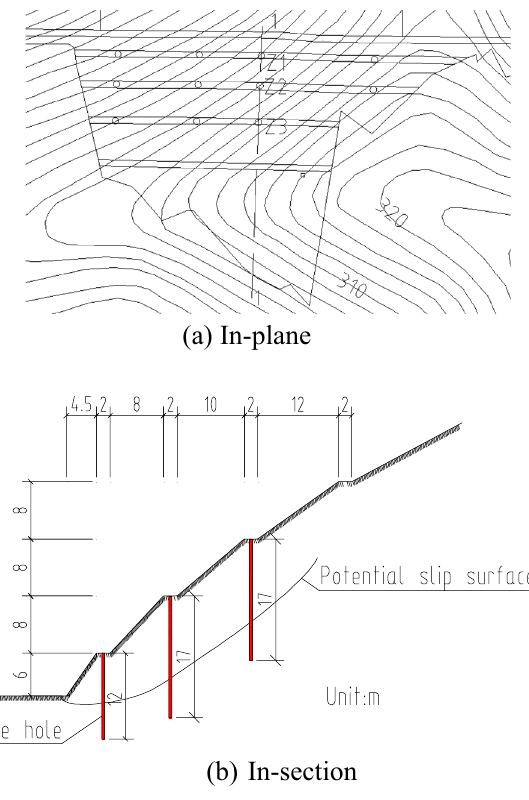
Figure 26. Arrangement of deep displacement